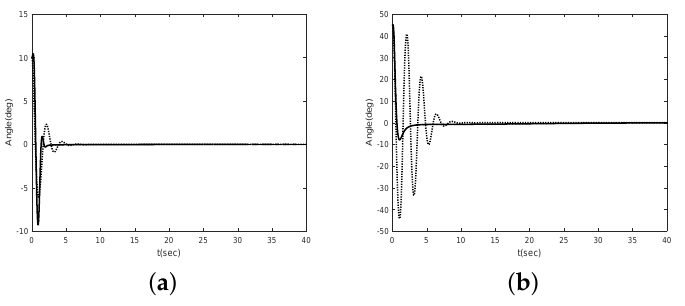
Figure 6. Angle of Segway without disturbance (solid : proposed method, dotted : LQR method): ( a ) θ ( 0 ) = 10 ◦ ; ( b ) θ ( 0 ) = 45 ◦